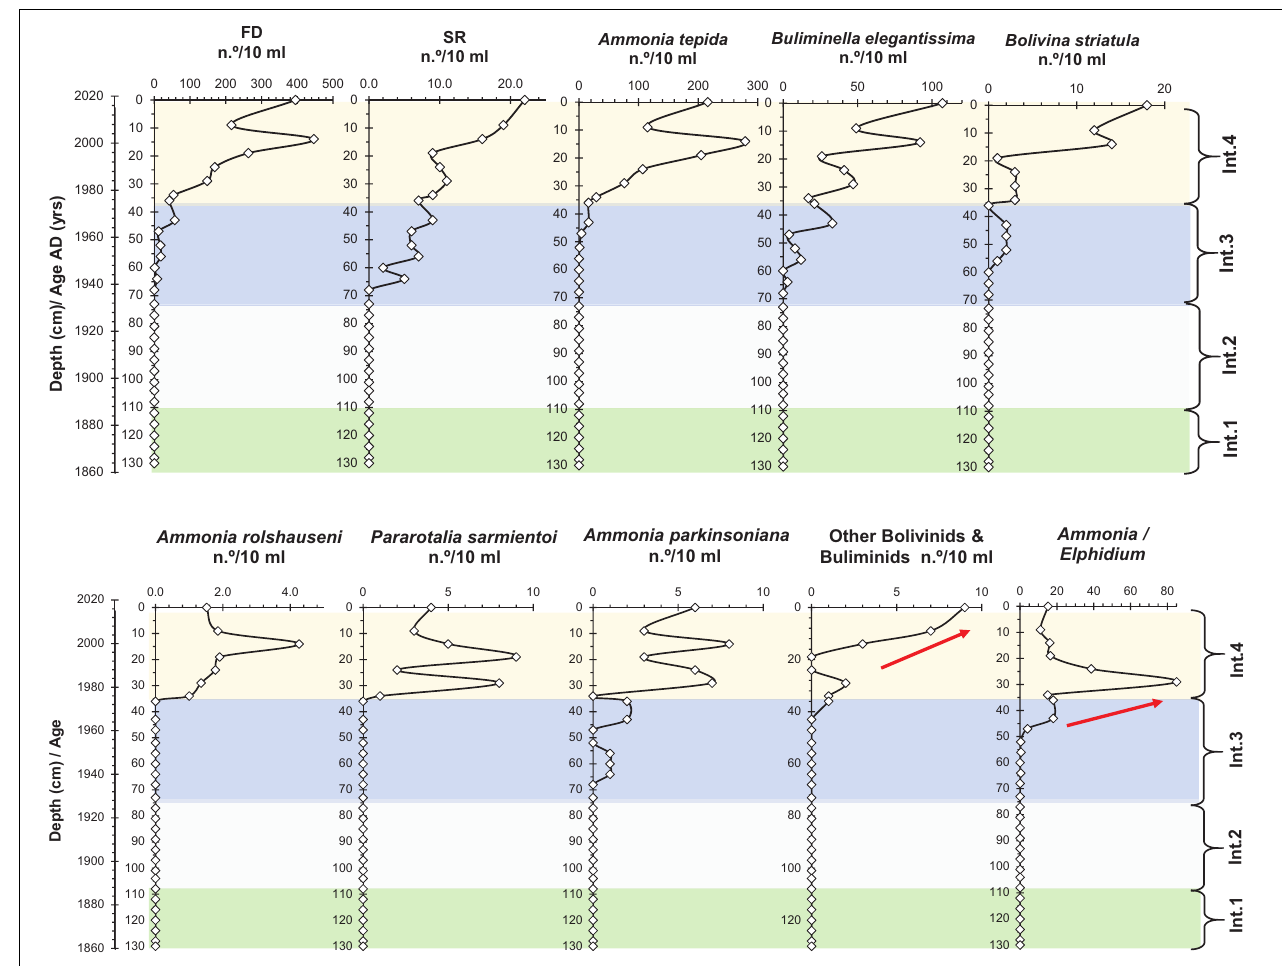
FIGURE 5 | Graphs as a function of depth and age (Anno Domini or AD) of: total benthic foraminiferal density FD) and abundance of several species and taxa, as well as species richness (SR) and Ammonia/Elphidium ratio found along core SP5. Based on the analyzed data, four intervals (Int.) were highlighted. The red arrows show a significant increase in the abundance of Bolivinids and Buliminids and Ammonia/Elphidium ratio.